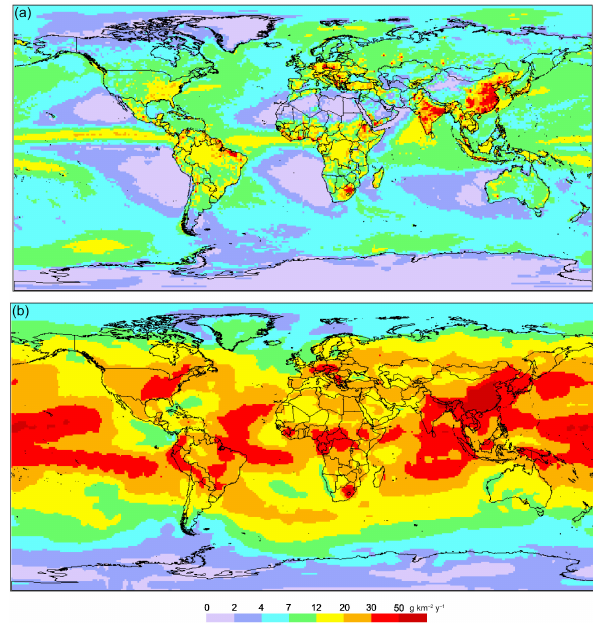
Figure 7. Global distribution of total (wet + dry) mercury deposi- tion flux in 2013 simulated by GLEMOS (a) and ECHMERIT (b)